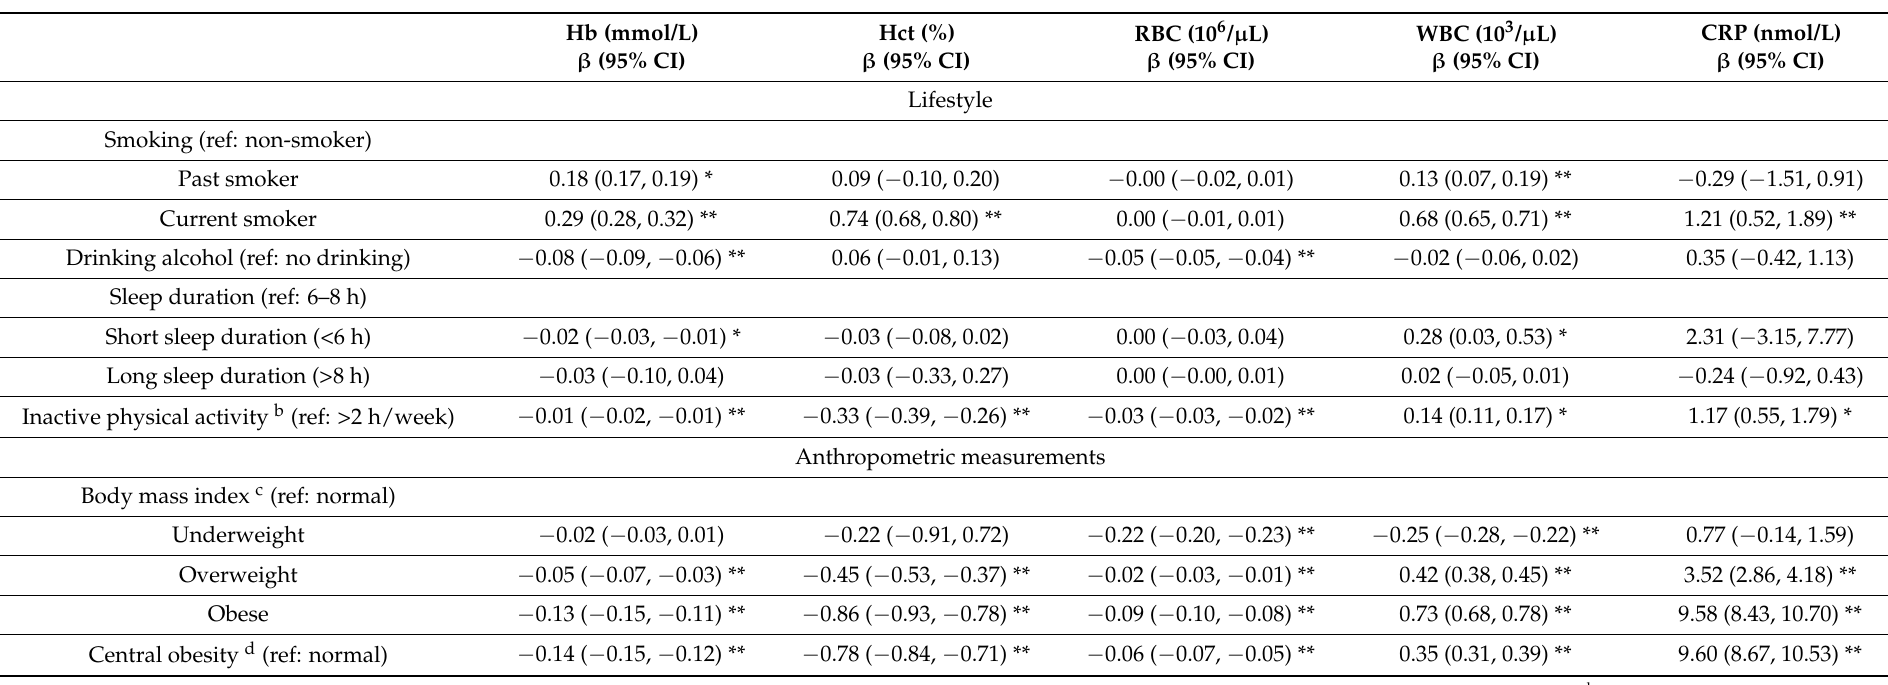
Table 3. Multivariable regression models for associations between lifestyle, anthropometric variables, and anemia–inflammation-related biomarkers a